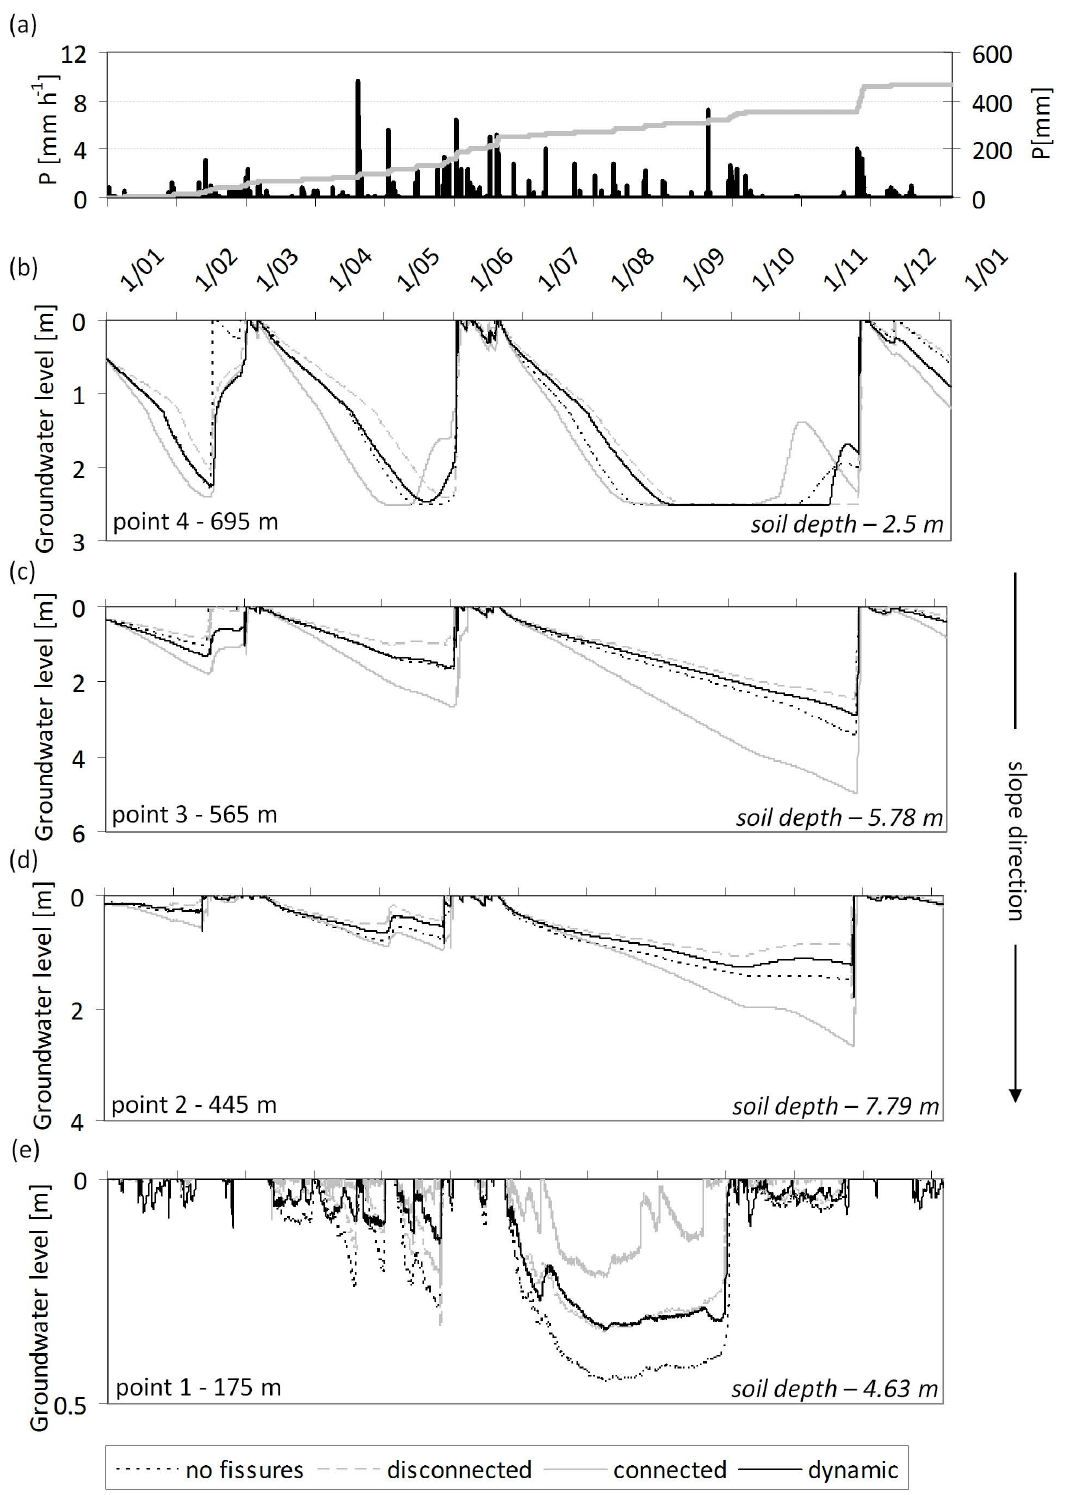
Fig. 9. Time series results of the one-year simulation period: (a) precipitation; (b – e) examples of groundwater level fluctuations observed in four points located along the landslide profile (major axes of the ellipse) from the toe (0m) to the scarp (800m) of the landslide. See Fig. 8a for the landslide profile and Fig. 3a for specific location of four